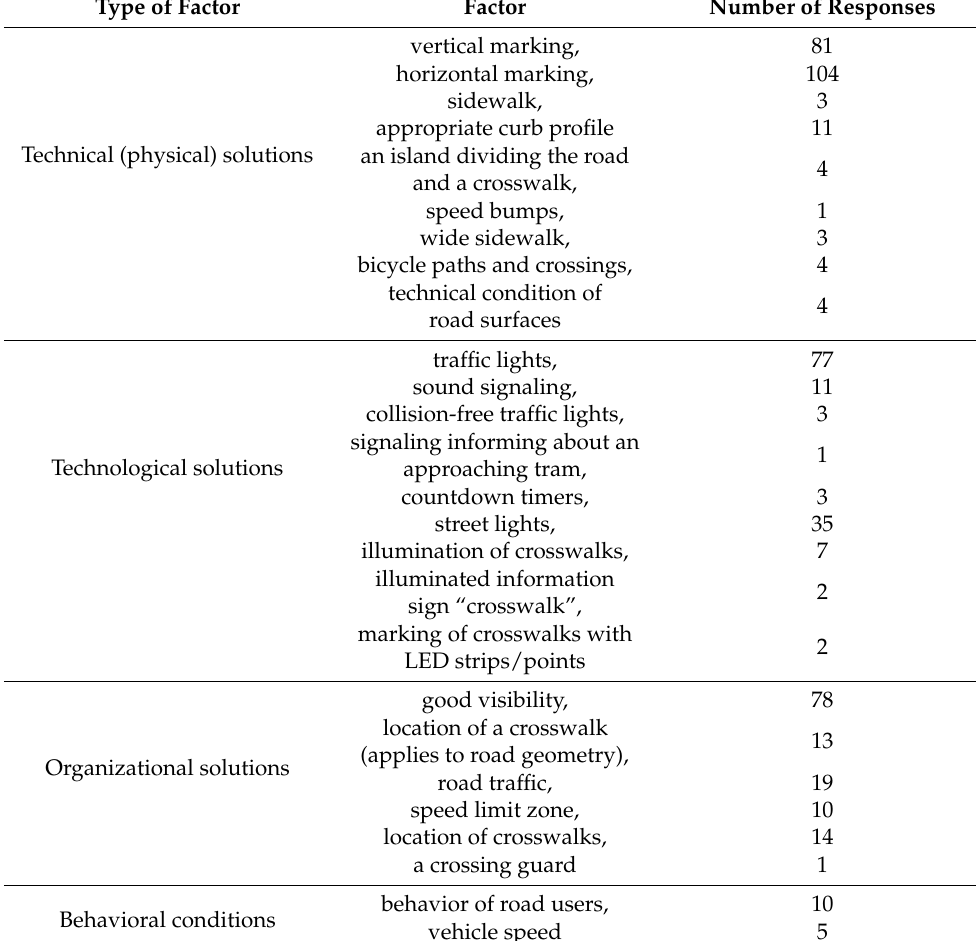
Table 3. Solutions influencing safety at pedestrian crossings according to identified types of